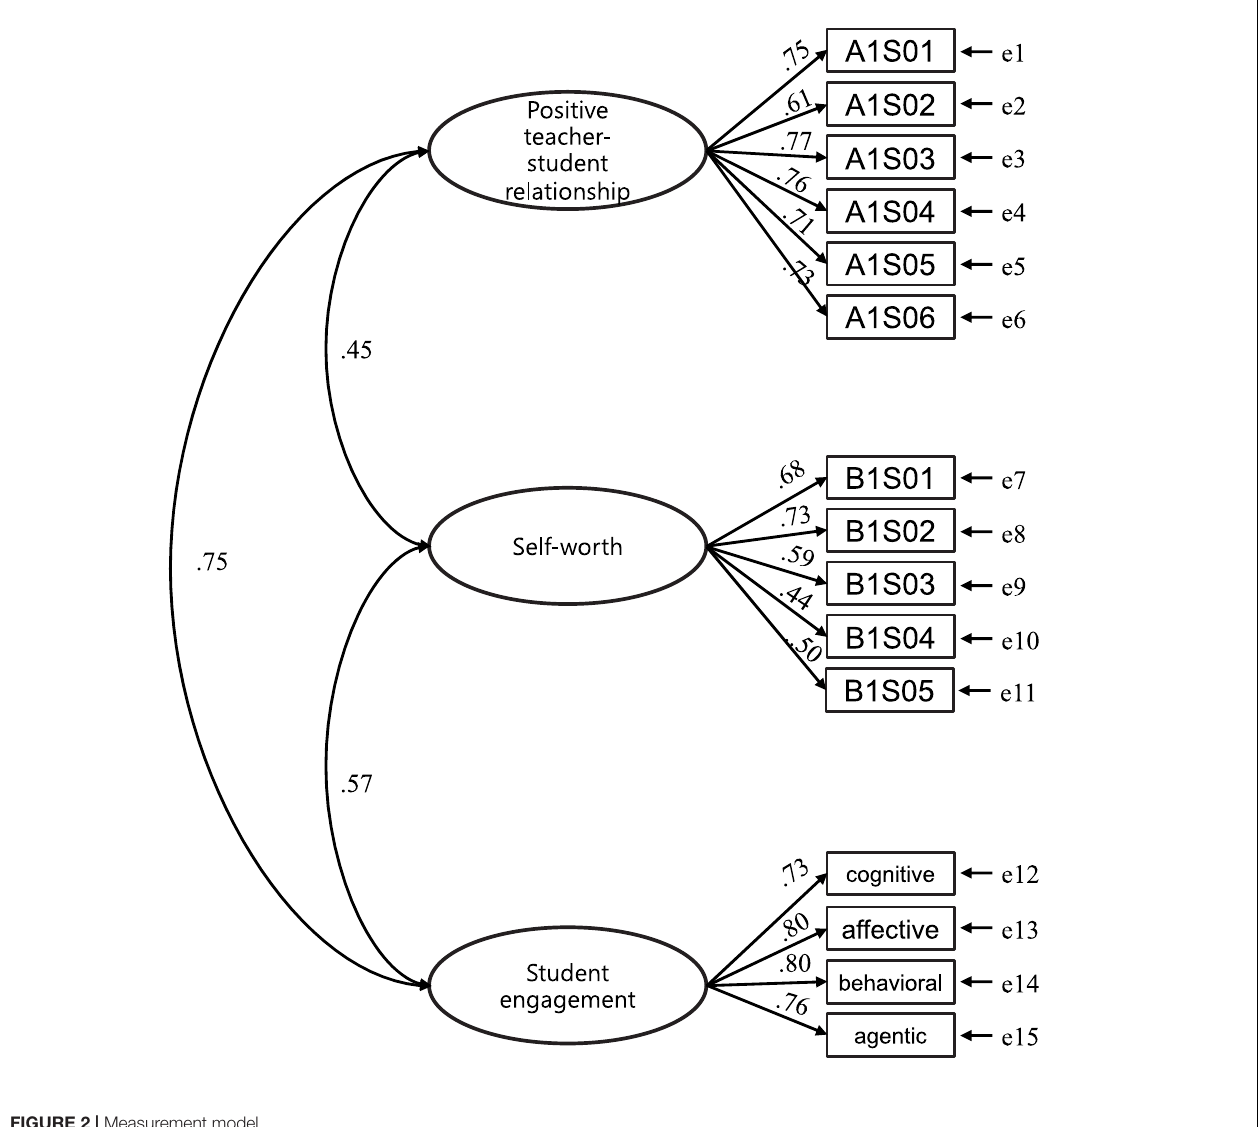
FIGURE 2 | Measurement